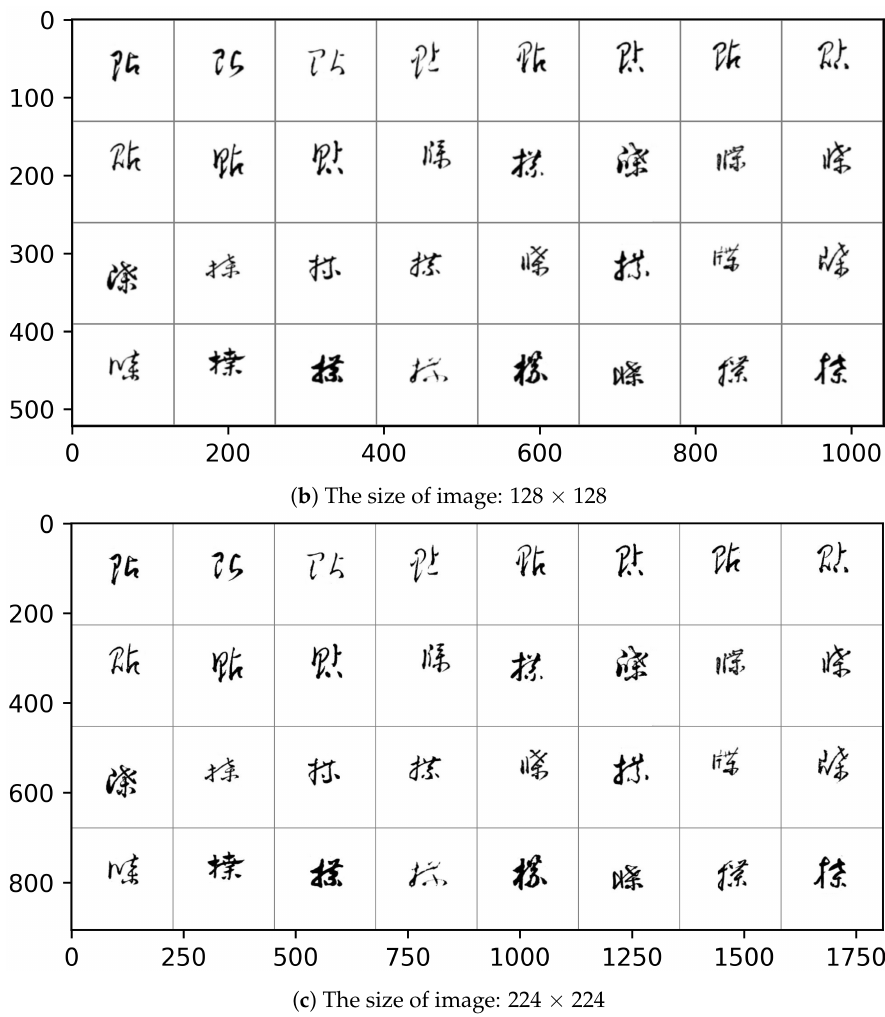
Figure 1. An example image according to the size of 32 × 32, 128 × 128, and 224 × 224,